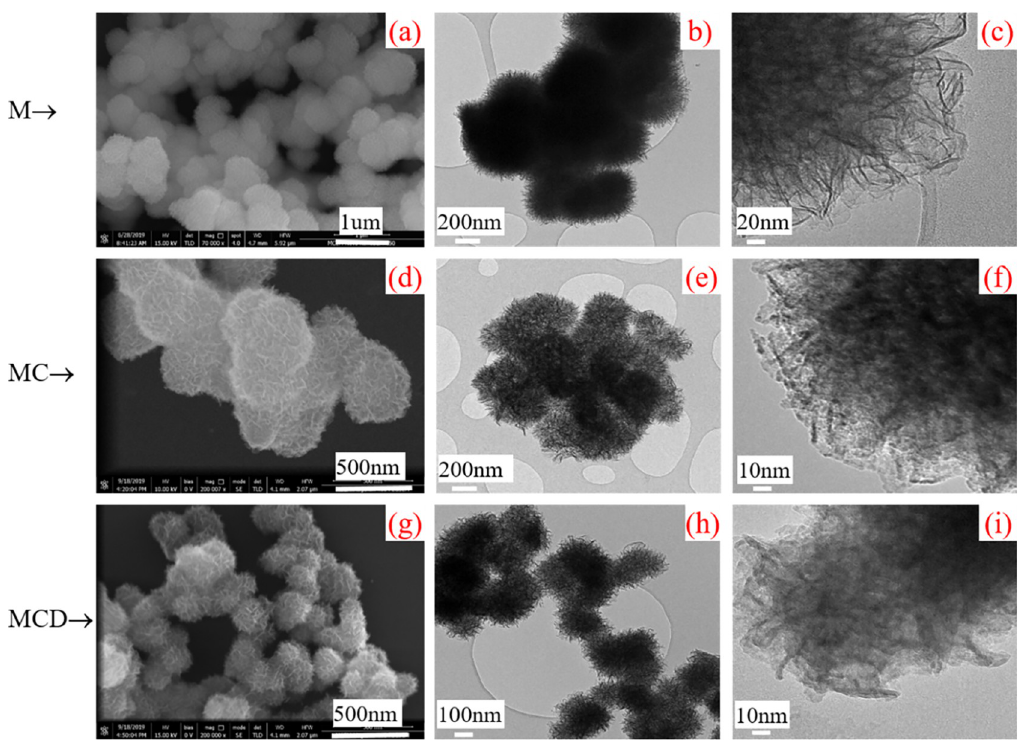
Fig 3. Characterization of produced manganese dioxide particles: (a) SEM image, TEM images at (b) a low magnification and (c) high magnification of product M; (d) SEM image, TEM images at (e) a low magnification and (f) high magnification of product MC; and (g) SEM image, TEM images (h) at a low magnification and (i) high magnification of product MCD.